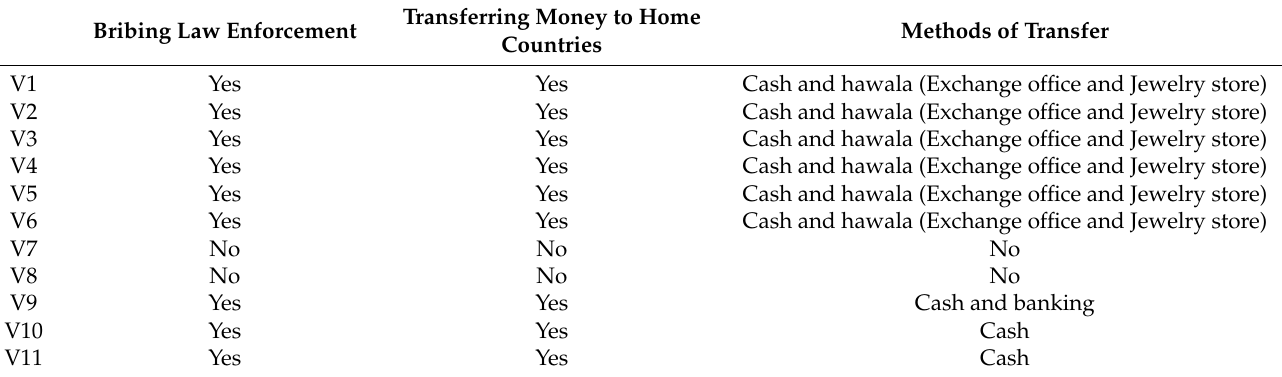
Table 6. Corruption and money transfer